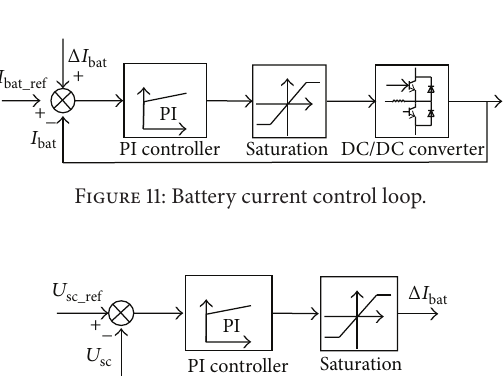
Figure 12: Supercapacitor voltage regulation loop.